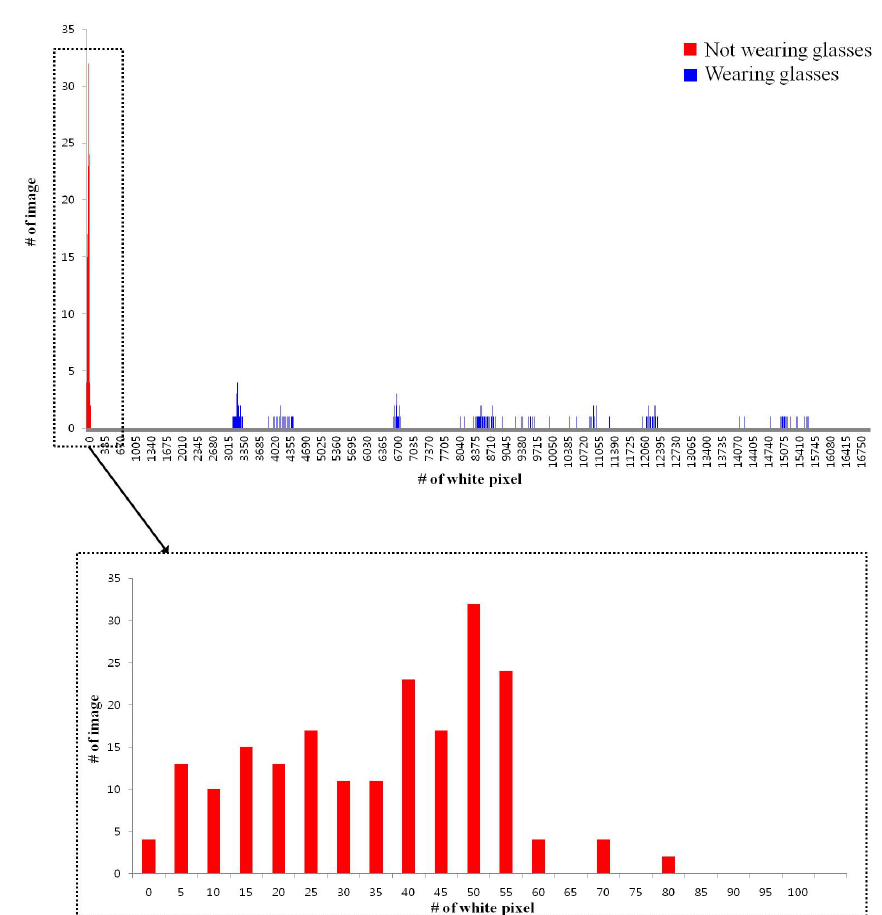
Figure 12. Two histogram distributions for not wearing and wearing glasses in terms of the numbers of white